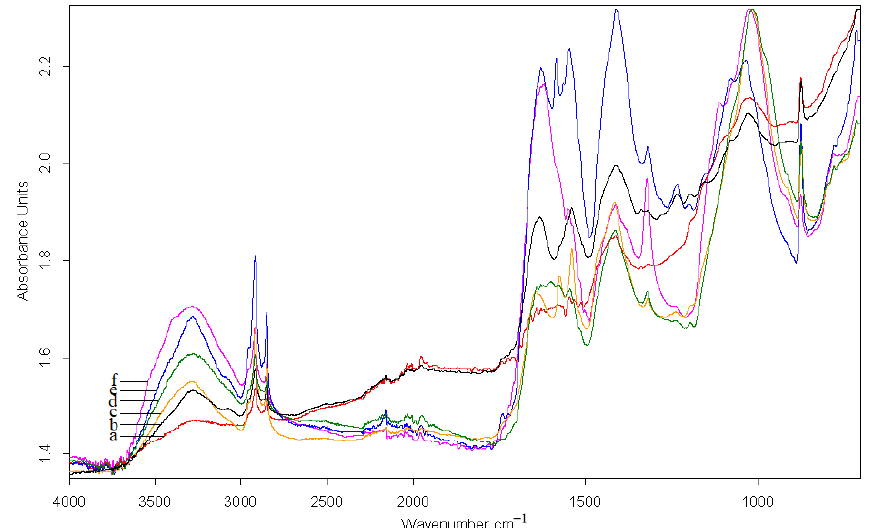
Figure 12. The FTIR spectra for the ink on the two documents: ( a ) S2-CA; ( b ) S1-PA; ( c ) S1-PR; ( d ) S1-CN; ( e ) S1-PV; and ( f ) S2-CN. Table 2. Representative peaks and spectral bands of the ions identified in the samples analyzed by ATR-FTIR.